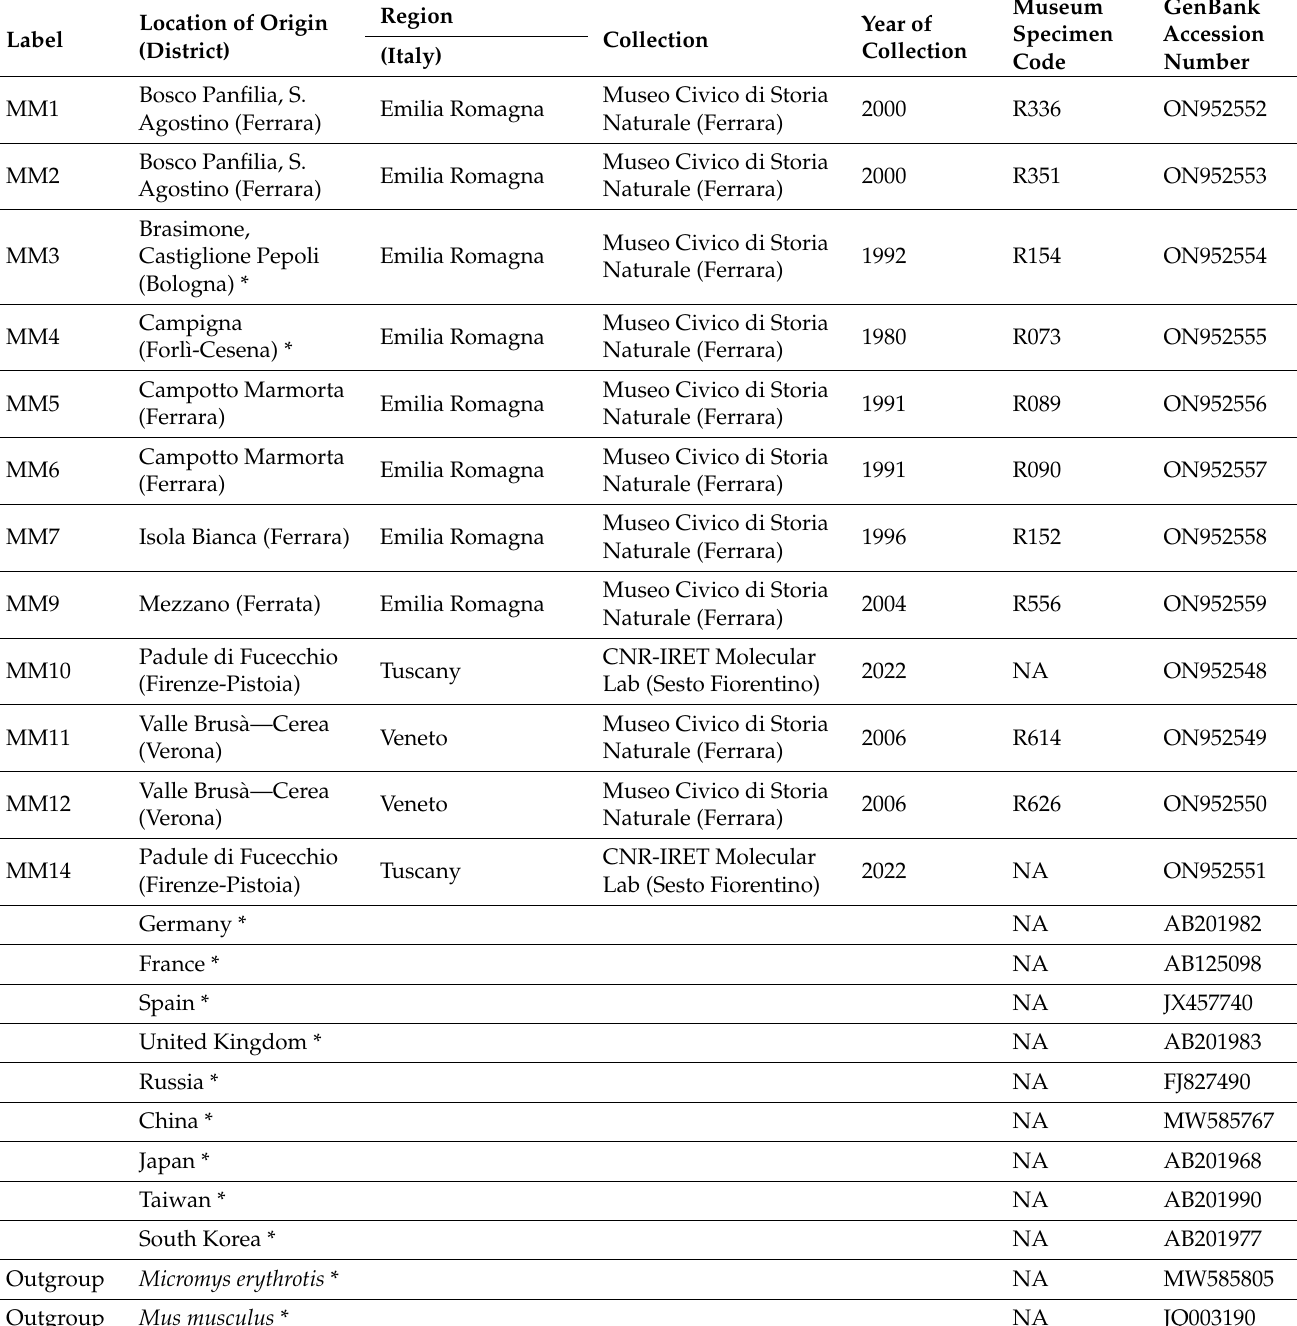
Table 1. Origins of harvest mouse samples analysed in our work: Label, Location and Region of origin, Year of collection, Museum specimen code, GenBank Accession Numbers. *: sequences from other authors. NA, not